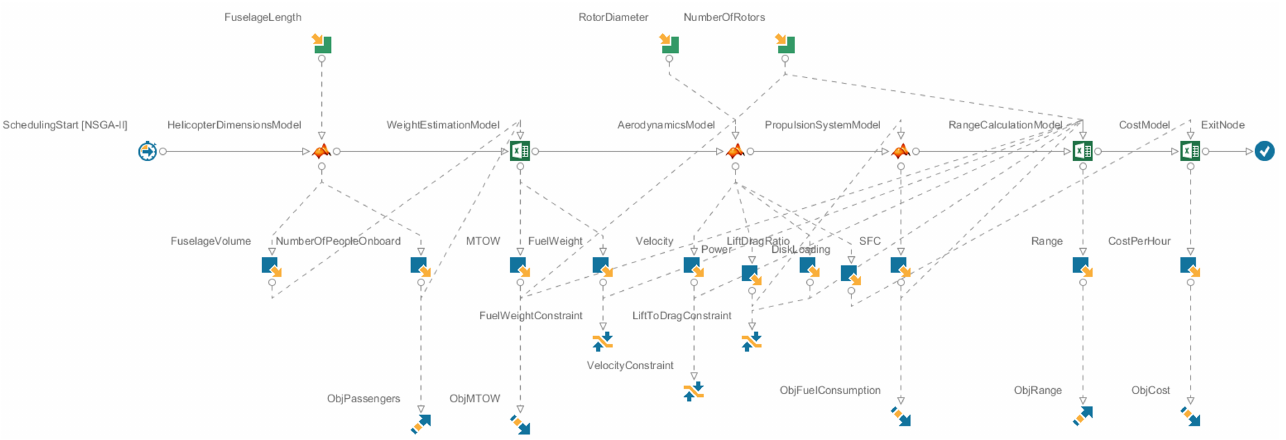
Figure 5. The modeFRONTIER optimization